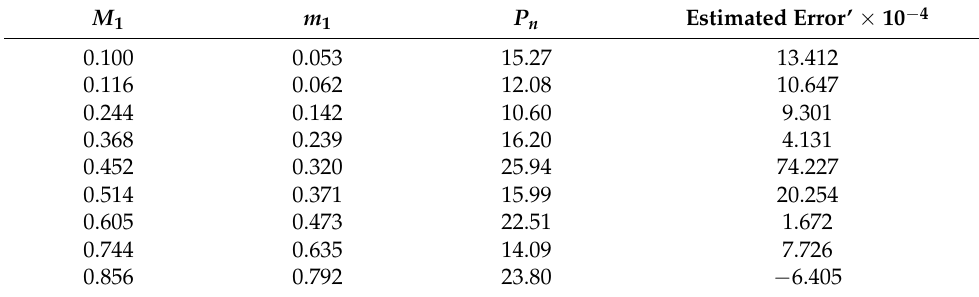
Table 8. The input data for medium conversion and r 1 = 0.65 and r 2 = 2.12 (MC3).